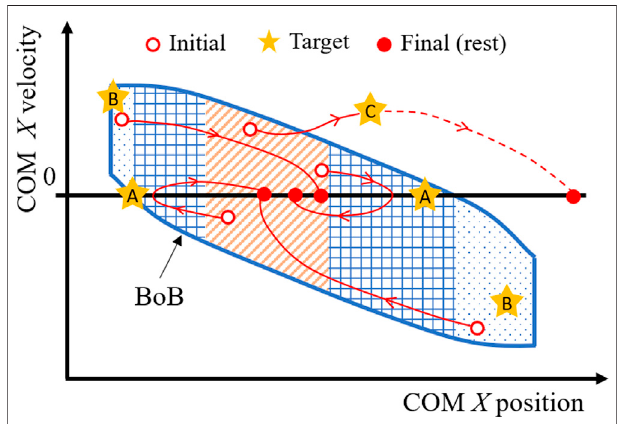
FIGURE 3 | Design of motor task for balance exercises (perturbation- basedandmotortask-based),wheretheCOMisguidedthroughinitial,target, and fi nal states. Targets A are selected progressively close to the reachable boundary margin, to fi nd the experimental maximum COM sway of a given subject, i.e., the capacity of withstanding internal perturbations. Targets B are selected progressively close to the viable boundary margin, to fi nd the experimental limits of external perturbations that a subject can withstand. Targets C are selected to drive a motor task at a known distance either inside or outside of the BoB and determine in real time the instantaneous state margin throughout the